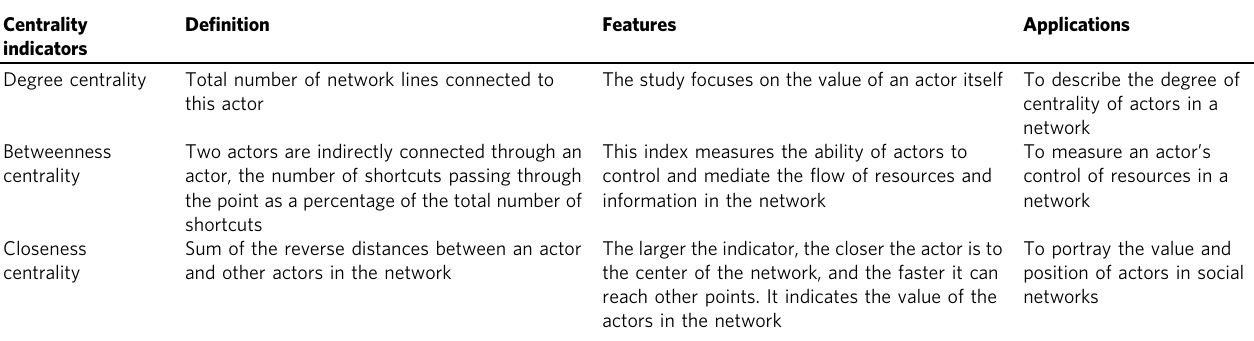
Table 1 Comparison of three centrality